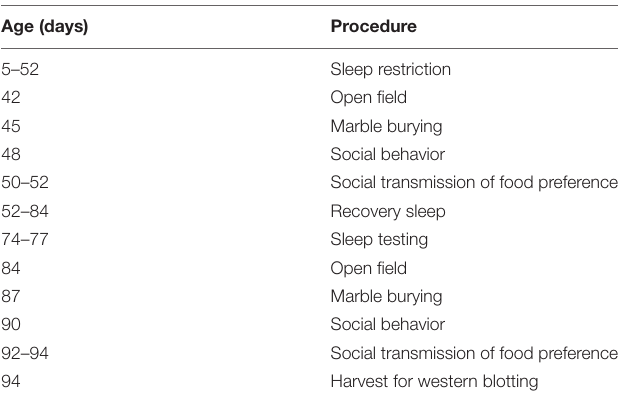
TABLE 1 | Experiment